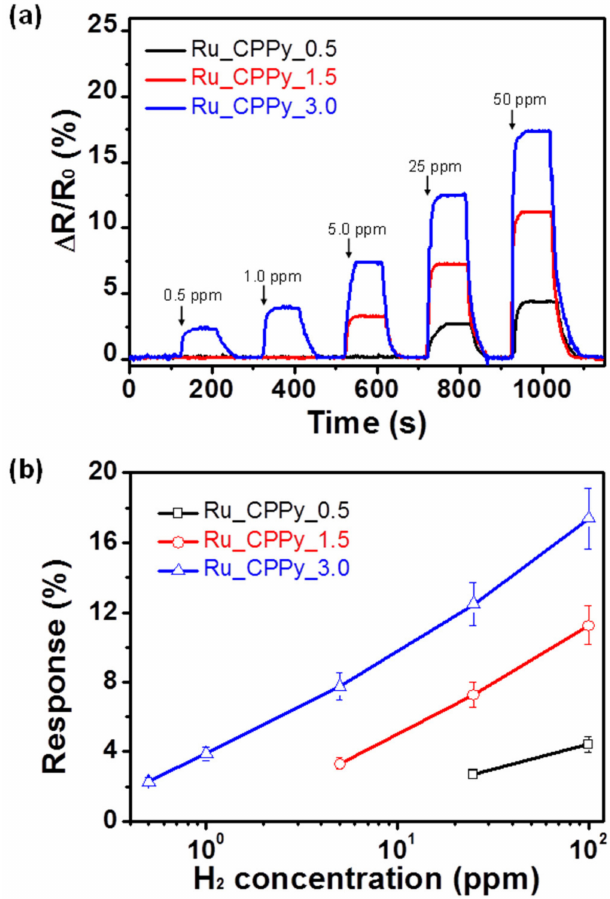
Figure 5. ( a ) The normalized resistance changes upon sequential exposure to various concentrations of hydrogen gas. ( b ) Calibration curves serve as a function of the hydrogen gas concentrations (black: Ru_CPPy_0.5; red: Ru_CPPy_1.5; blue: